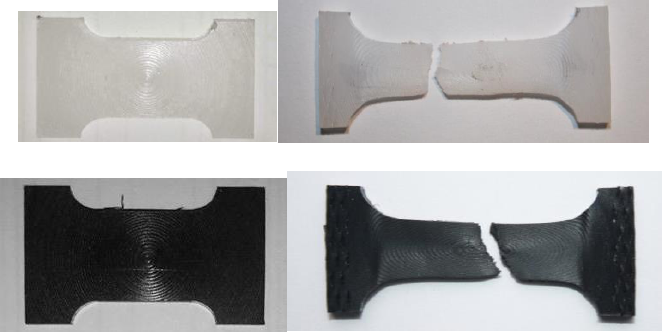
Figure 7. Pictures of tensile test specimens for the white and black base materials before and after the test.